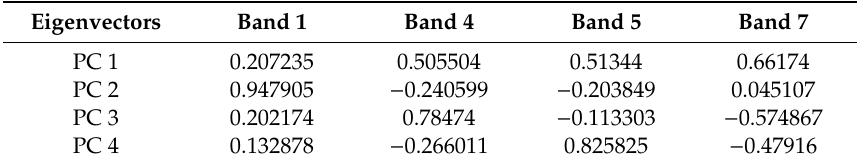
Table 2. Eigenvectors of the principal component analysis on a spectral subset of the ASTER data for detecting the argillic alteration zones in the study area.